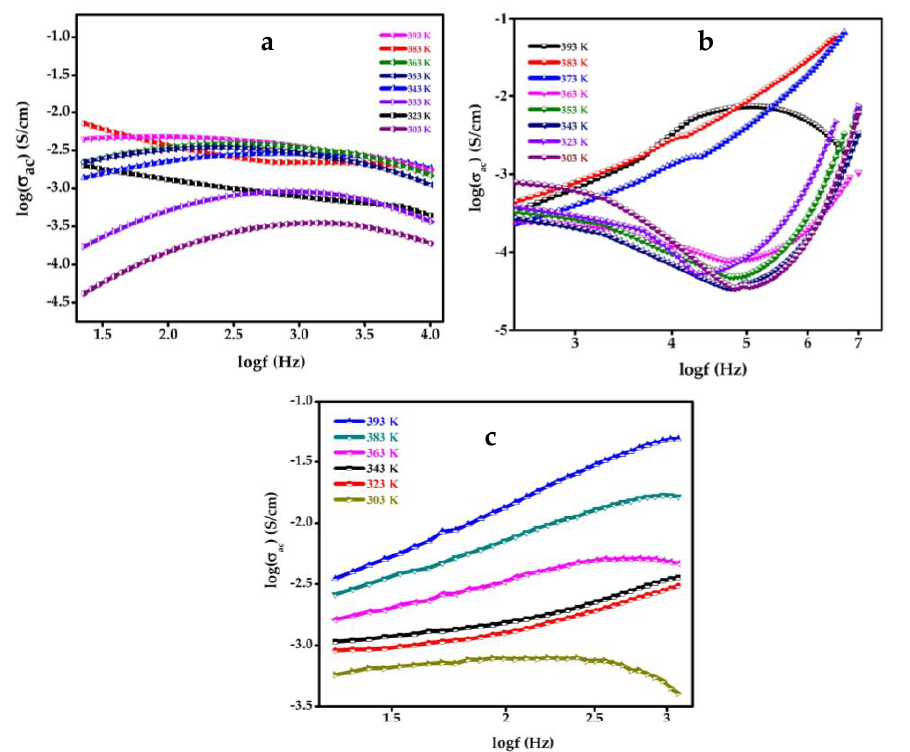
Figure 14. Variation in AC conductivity for ( a ) SnO 2 QDs, ( b ) GO, and ( c ) SGP2 composite film at different temperatures.